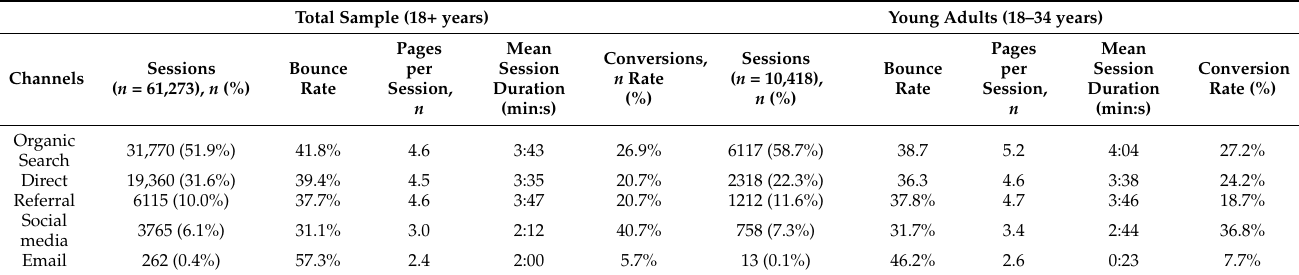
Table 6. User acquisition channels and engagement metrics.